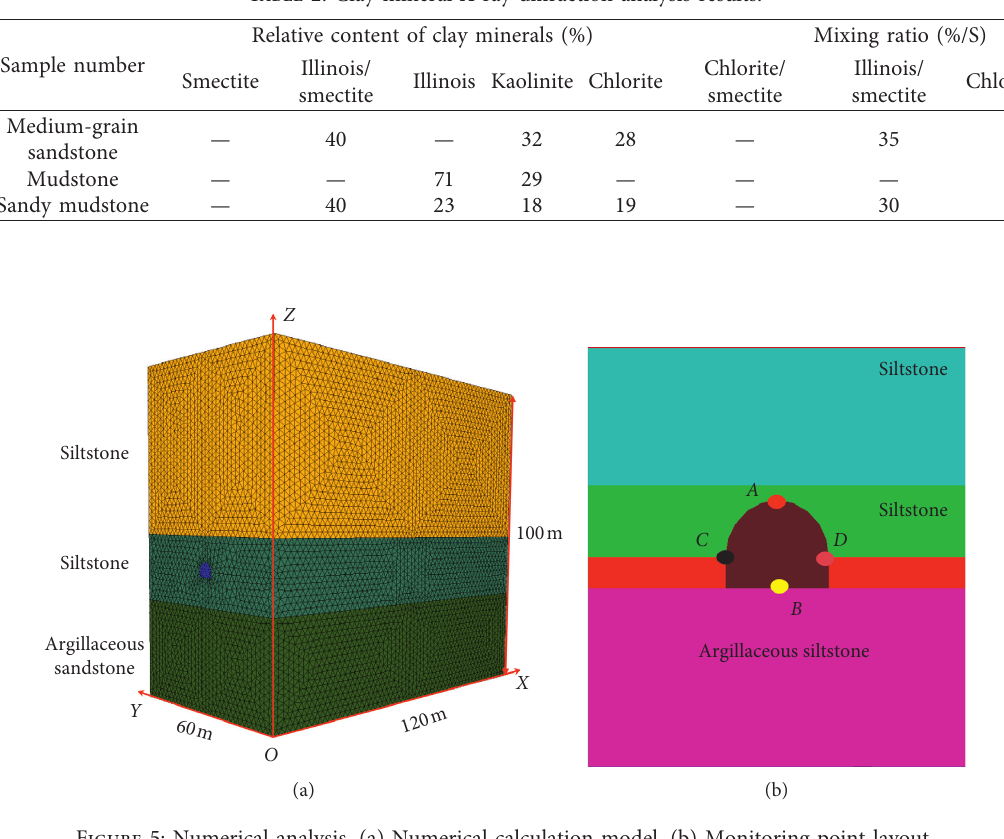
Table 2: Clay mineral X-ray diffraction analysis results.